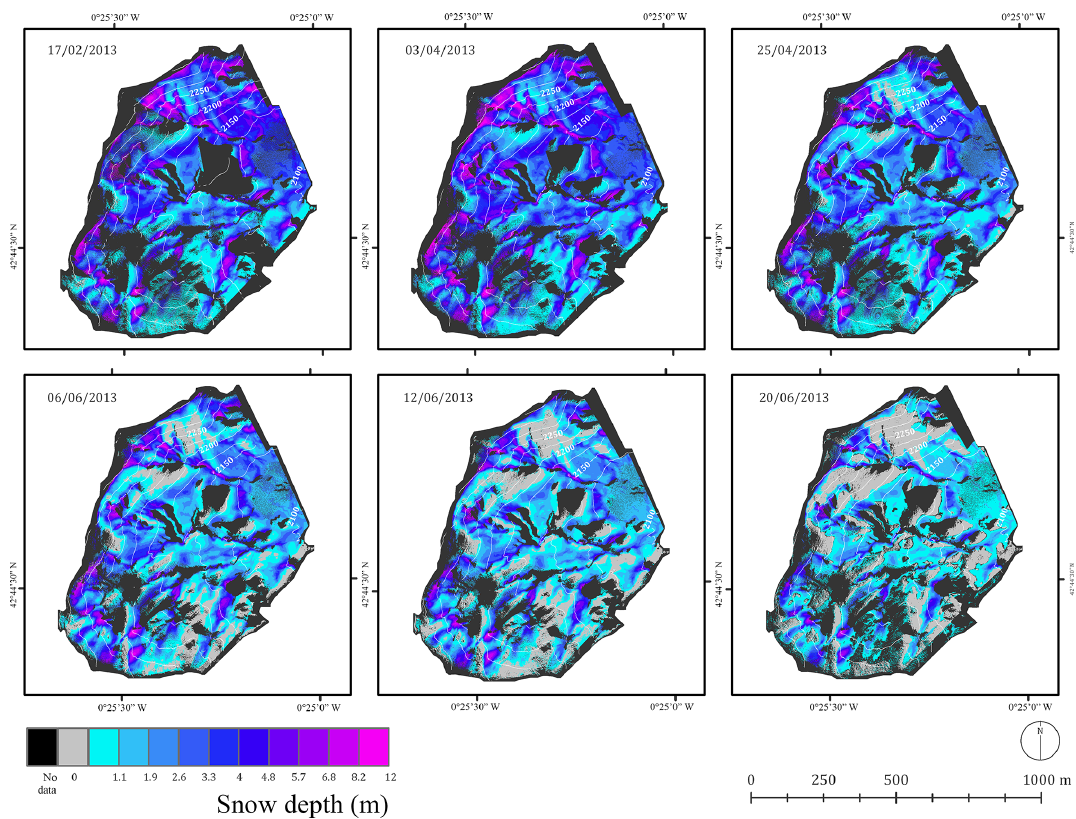
Figure 5. Snow depth distribution maps obtained for the six TLS acquisition dates of the 2012/13 snow season.